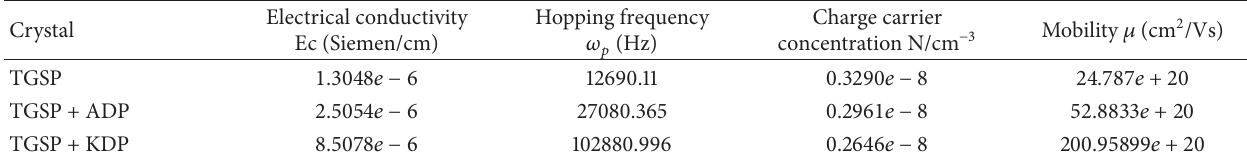
Figure 6: Powder XRD pattern of (a), TGSP (b), TGSP + ADP (c), and TGSP + KDP crystals. Table 6: Electrical conductivity